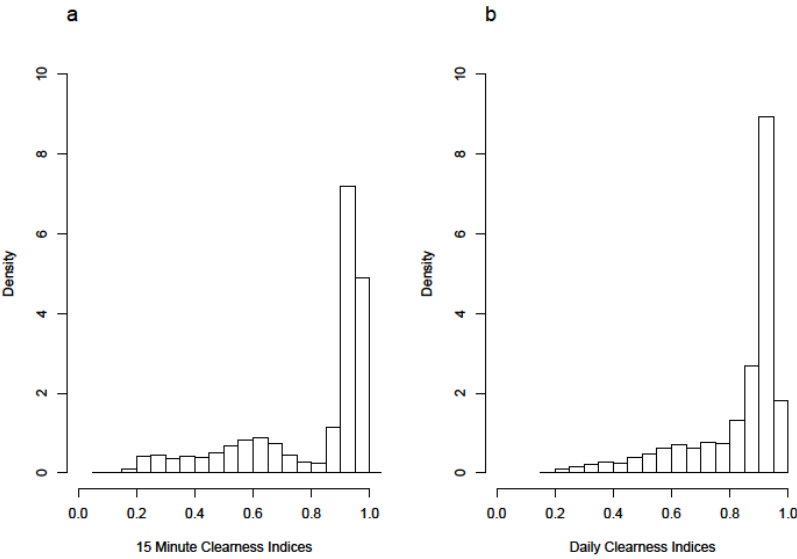
Figure 2. Annual distributions of ( a ) Subdaily and ( b ) daily clearness indices ( K t ) from CAMS .